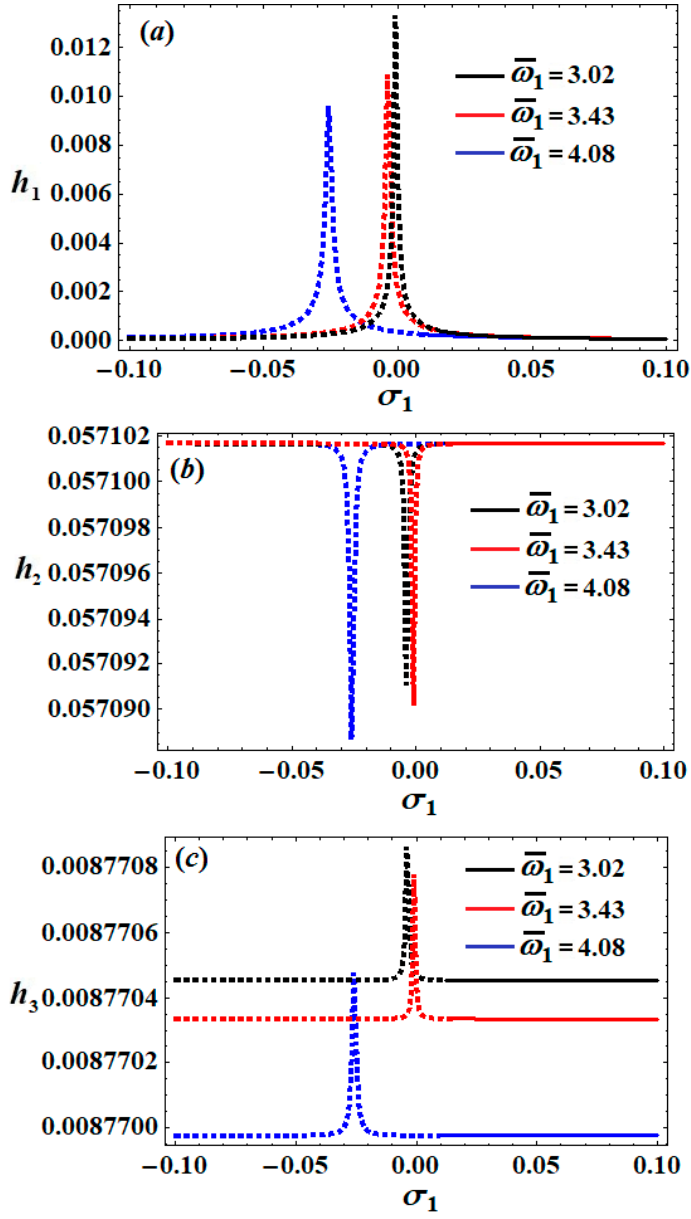
Figure 11. The change of the frequency responses of h ω 1 = ( 3.02,3.43,4.08 )